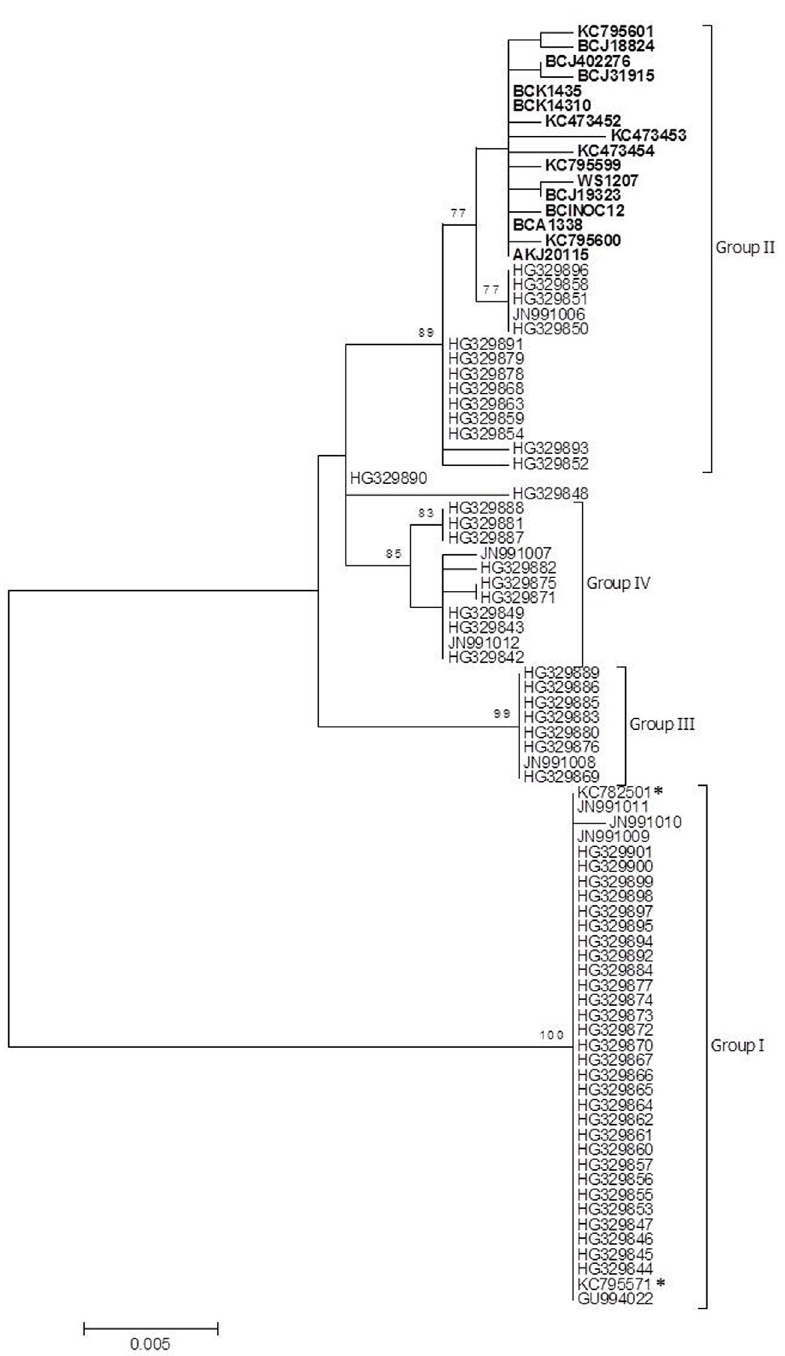
Fig 3. Molecular phylogenetic analysis of unique partial sequences of Piscine reovirus segment S1 derived from fish in the North American Pacific region, Chile and Norway. A total of 830 out of 1,081 nucleotides were used in the analysis. Phylogenetic relationships were inferred using the maximum likelihood method based on the Kimura 2-parameter model. Bootstrap analysis (1,000 replicates) was used to validate tree topology. The numbers above the branches represent the percentage of trees in which the taxa are clustered; only nodes with (cid:3) 70% bootstrap support are shown. The North American Pacific samples are designated with bold, the Chilean sequences are designated with a star, and the Norwegian sequences are not designated. Sequences derived from this study include BCJ18824, BCJ402276, BCJ31915, BCK1435, BCK14310, WS1207, BCJ19323, BCINOC12, BCA1338, AKJ20115 (See Table 2 for additional sample identification, samples from Norway and Chile are described in S1